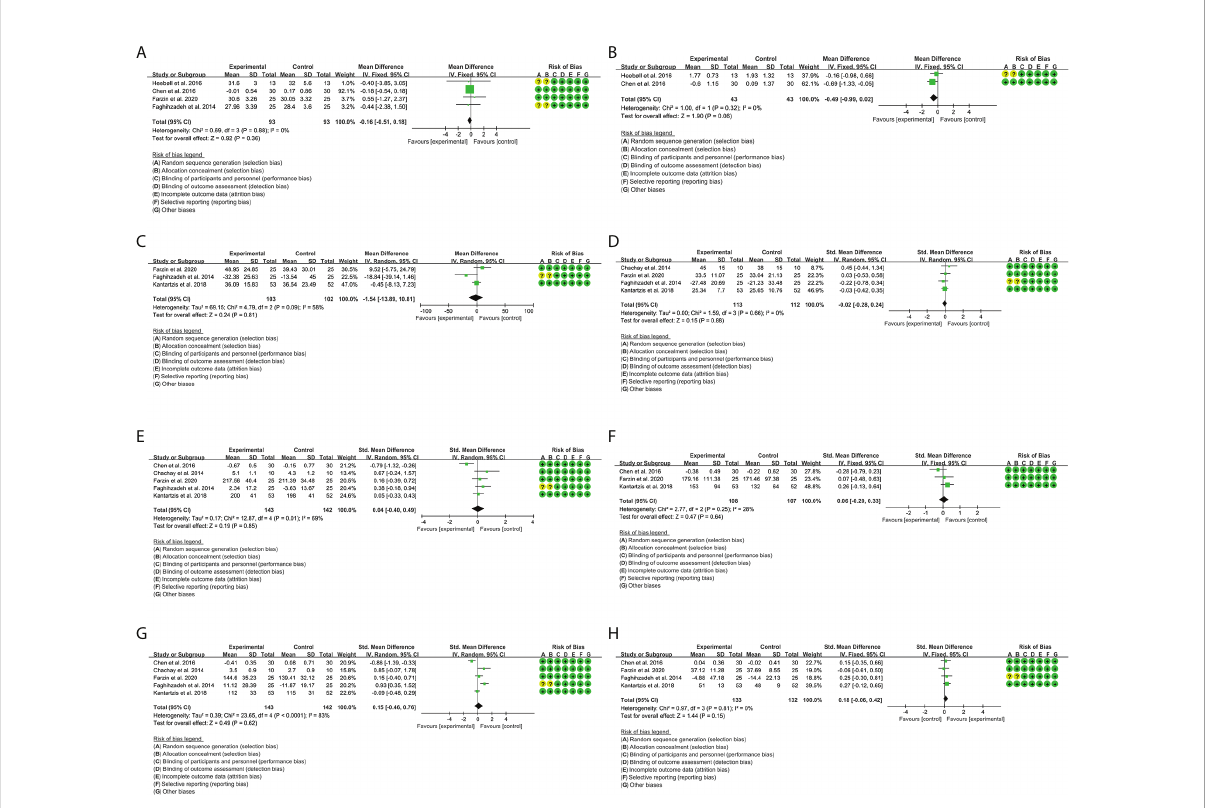
FIGURE 4 Outcomes in resveratrol treatment ( A : BMI; B : HOMA-IR; C : ALT; D : AST; E : TG; F : TC; G : LDL-C; H :